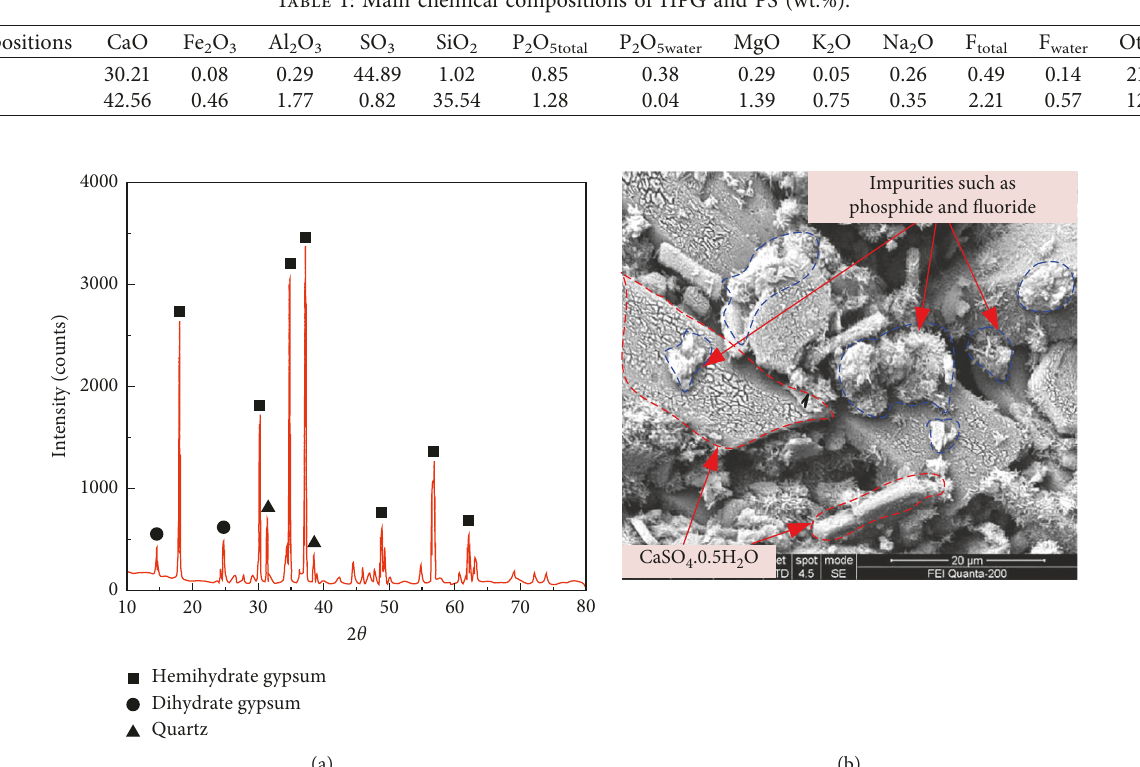
Figure 1: Results of X-ray diffraction and scanning electron microscopy (SEM) of HPG. (a) XRD image; (b) SEM image.